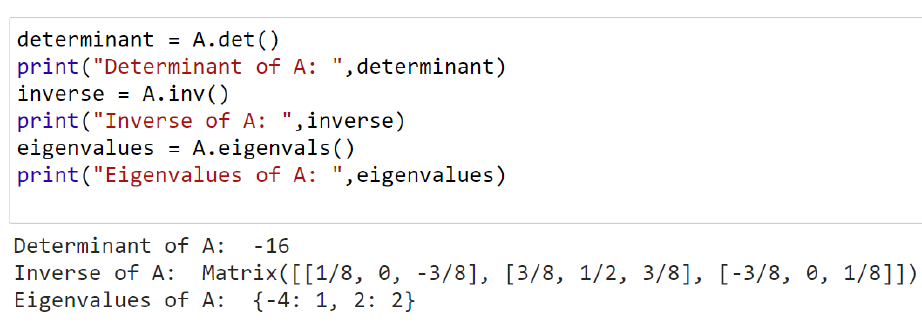
Figure 9. Matrix